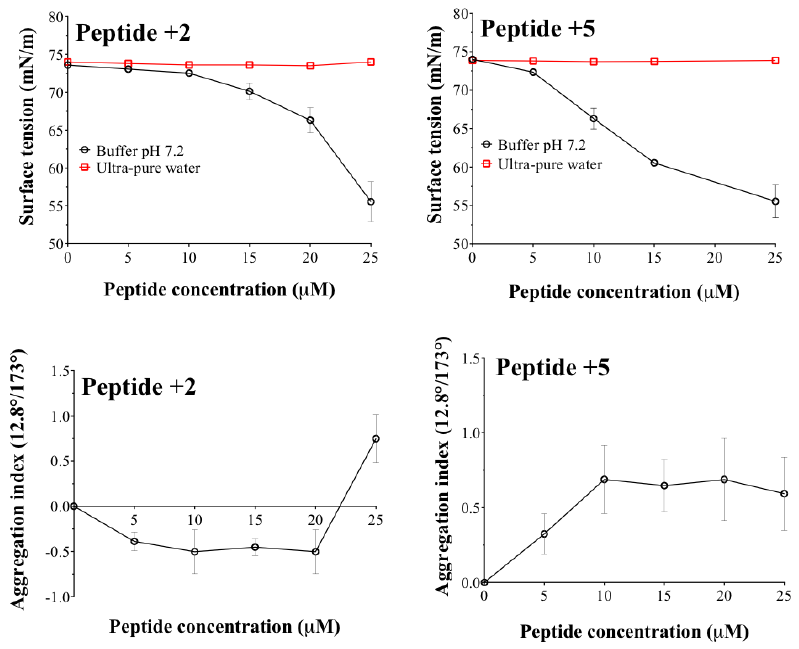
Figure 4. Changes in aggregation index and surface tension as a function of peptide concentration. 153